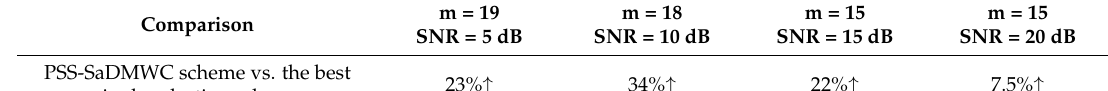
Table 4. Comparison of the maximum promoting